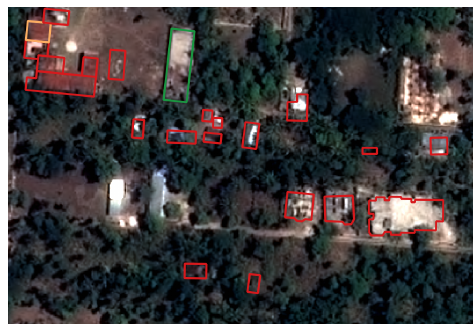
Figure 10. Registration of the database in Haiti: buildings outlined in red did not match any segment